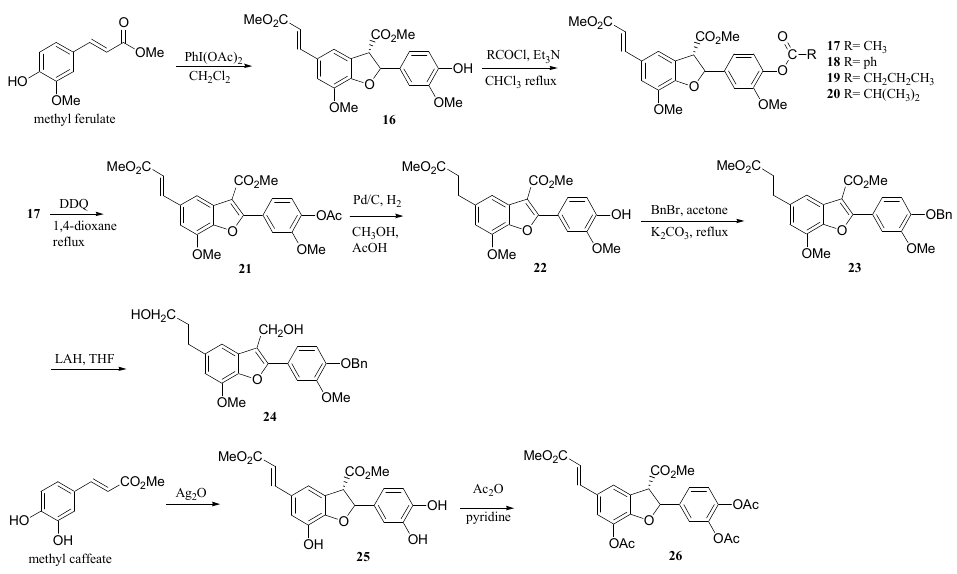
Table 1. Growth inhibition of salvinal derivatives against human cancer